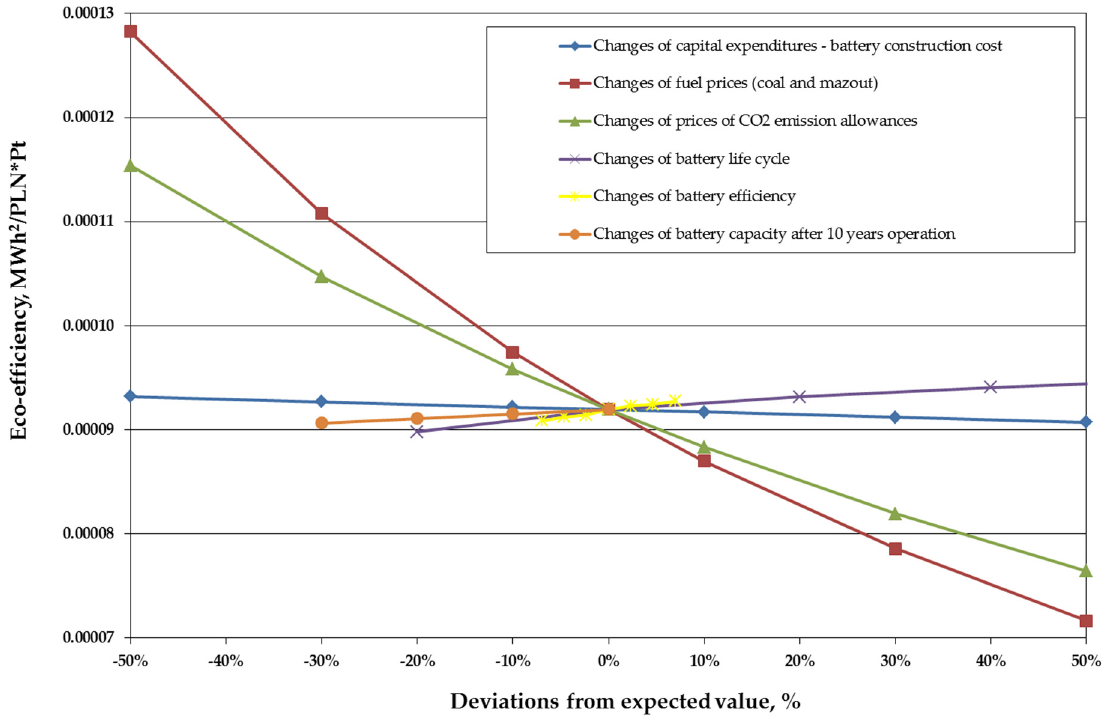
Figure 4. Graphic interpretation of the sensitivity analysis results for the sensitivity of electricity production technology in a coal-fired power plant using a battery.